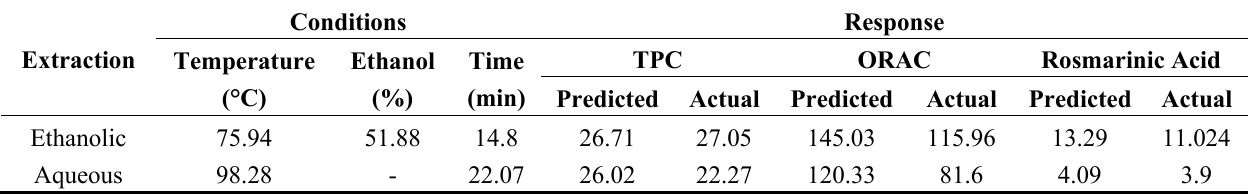
Table 6. The optimal responses given by RSM for the two types of extractions. Conditions Extraction